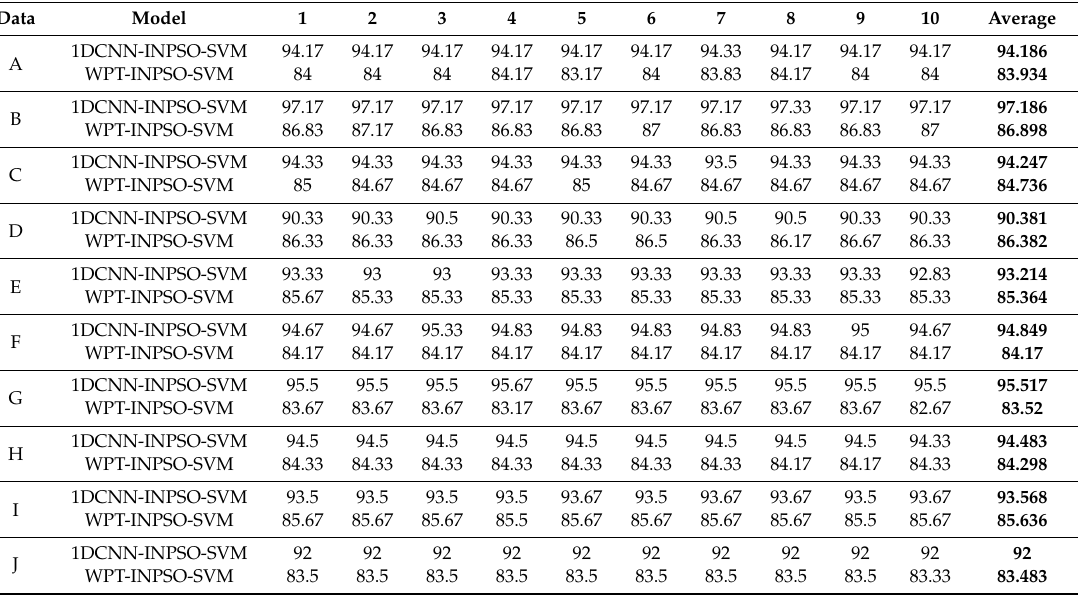
Table 8. Recognition results of ten trials using di ff erent